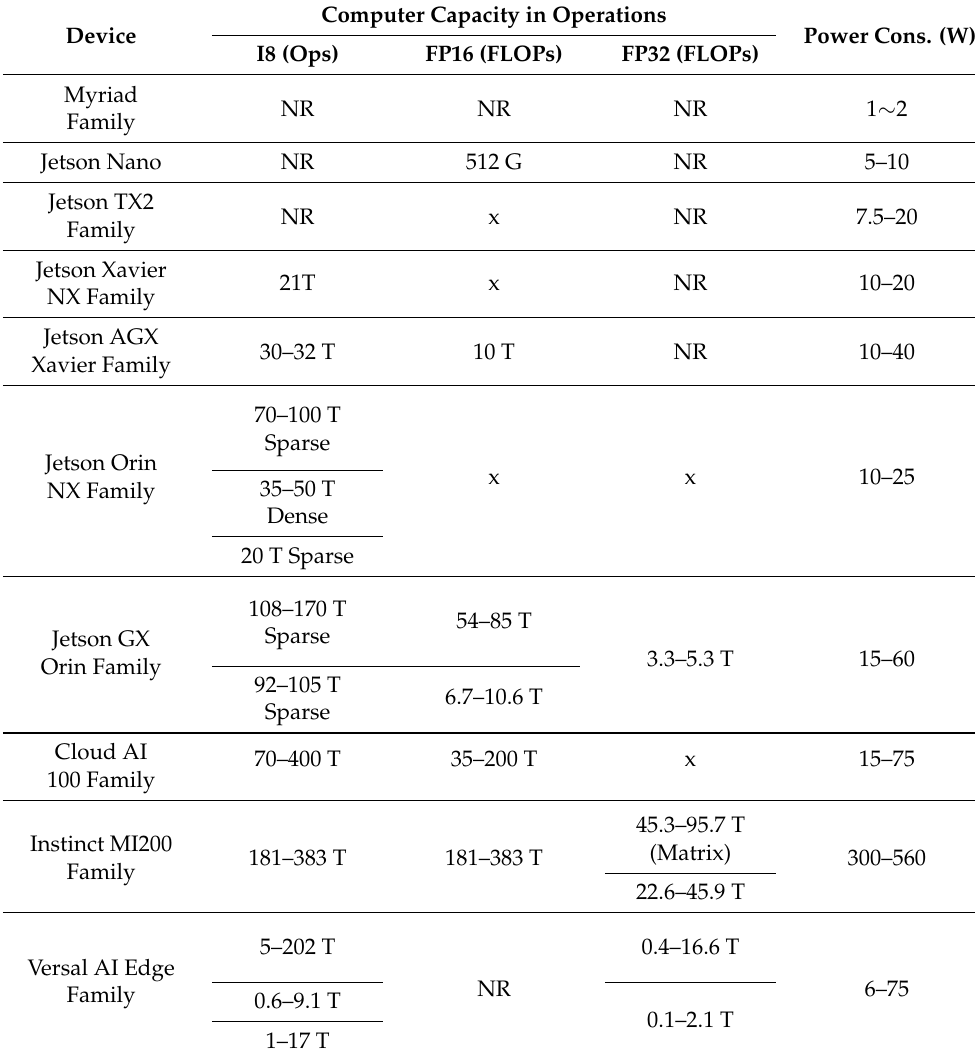
Table 4. Trade-off of the AI chipsets and boards under consideration: computing capacity per operation.